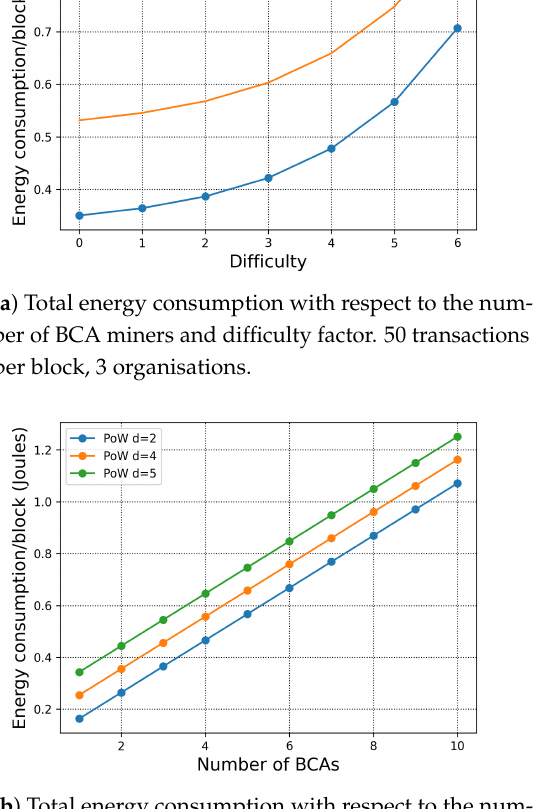
Figure 4. Total energy consumption with respect to the difficulty